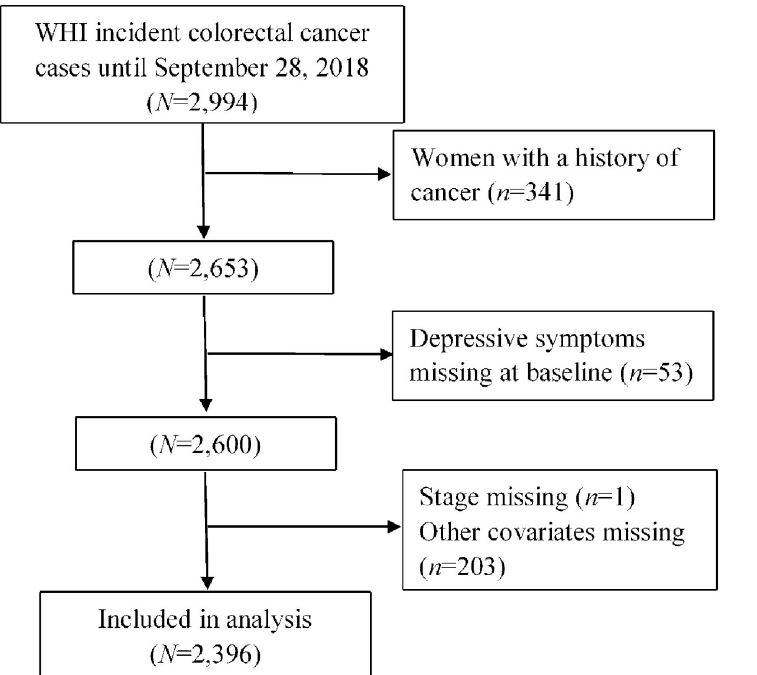
Fig 1. Flow diagram of participants included in the